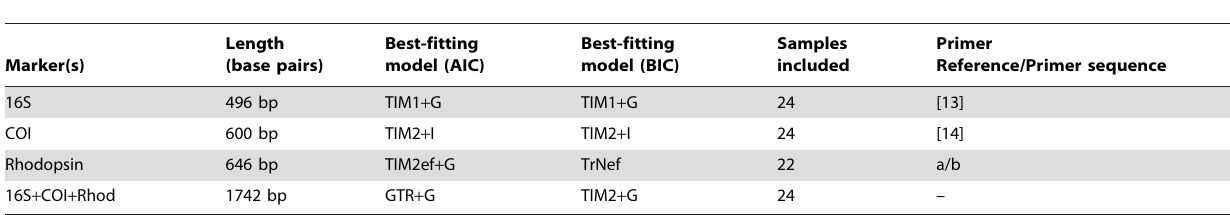
Table 1. Summary of genetic markers and parameters and total sample number used in analyses.